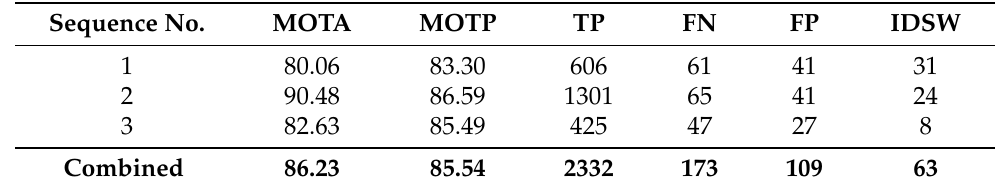
Table 9. Scenario 4—category 2 Quantitative results of the tracker’s performance to track objects of category 2 (tugboat) in scenario 3. Scenario 3 consists of three sequences involving both moving and static objects, dynamic movement of the camera’s viewpoint are